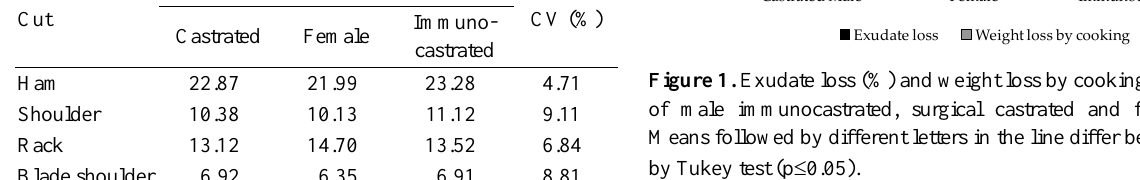
Table 3. Yield (%) of commercial cuts of male immunocastrated, surgical castrated and female pigs Cut